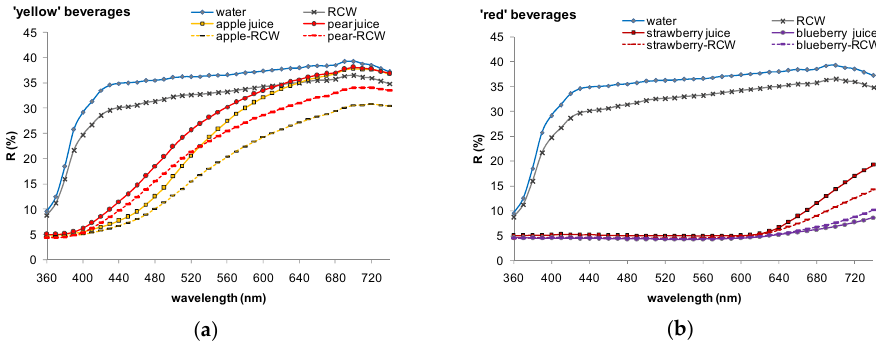
Figure 3. Reflectance spectra of water, ricotta-cheese whey (RCW), commercial pectin-free juices diluted to 14% SSC with water (fruit juice), and beverages before pasteurization (RCW-fruit): ( a ) apple and pear ‘yellow’ beverages; ( b ) strawberry and blueberry ‘red’ beverages.